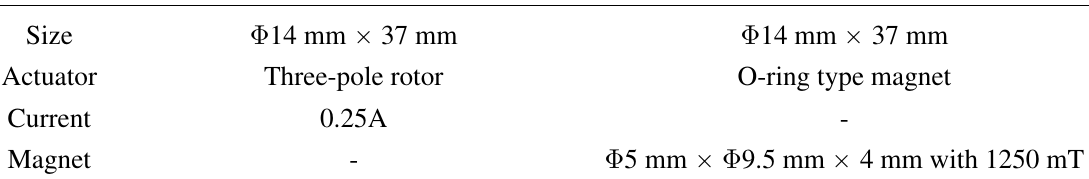
Table 1. Specifications of magnetic actuated microrobot.